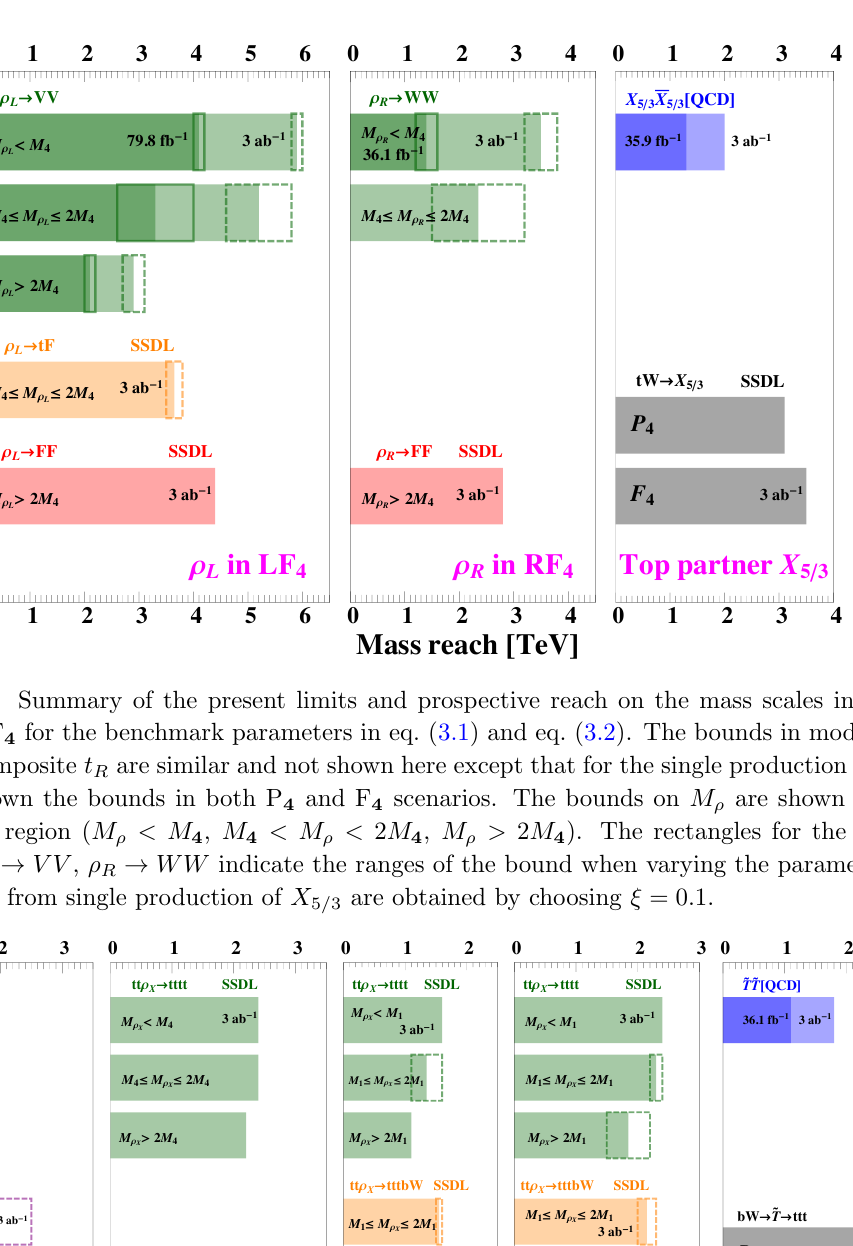
Figure 13. Summary of the present limits and prospective reach on the mass scales in models involving the singlet spin-1 resonance XP(F) 4 ; 1 for the benchmark parameters in eq. (3.3) and eq. (3.4). The bounds on M (cid:26) are shown in three kinematical region ( M (cid:26) < M 4 , M 4 < M (cid:26) < 2 M 4 , M (cid:26) > 2 M 4 ). The rectangles indicate the ranges of the bound when varying the parameter M 4 ; 1 . The bounds from single production of ~ T are obtained by choosing (cid:24) = 0 : 1.